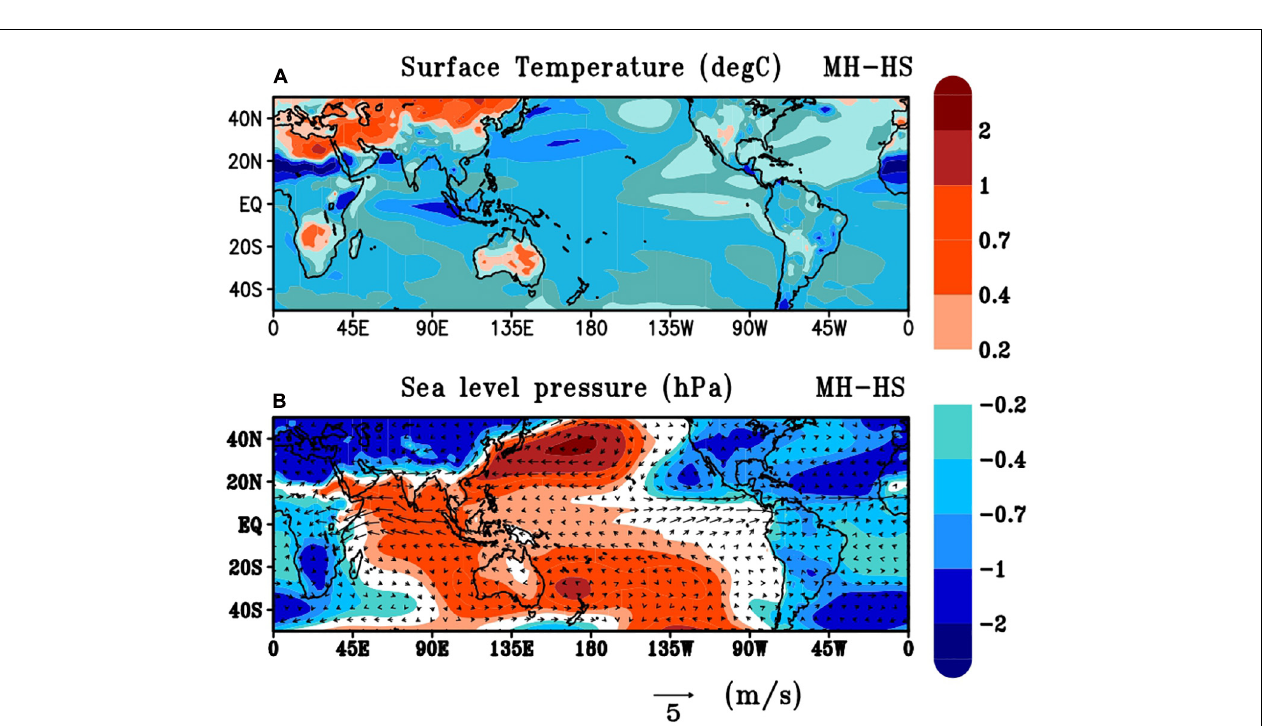
FIGURE 4 | (A) Spatial distribution of the simulated surface temperature ( ◦ C) difference in the time-averaged JJAS between MH and HS. (B) Spatial distribution of the simulated sea level pressure (hPa) and overlaid by the monsoon winds (m/s) at 850 hPa difference in the time-averaged JJAS between MH and HS.